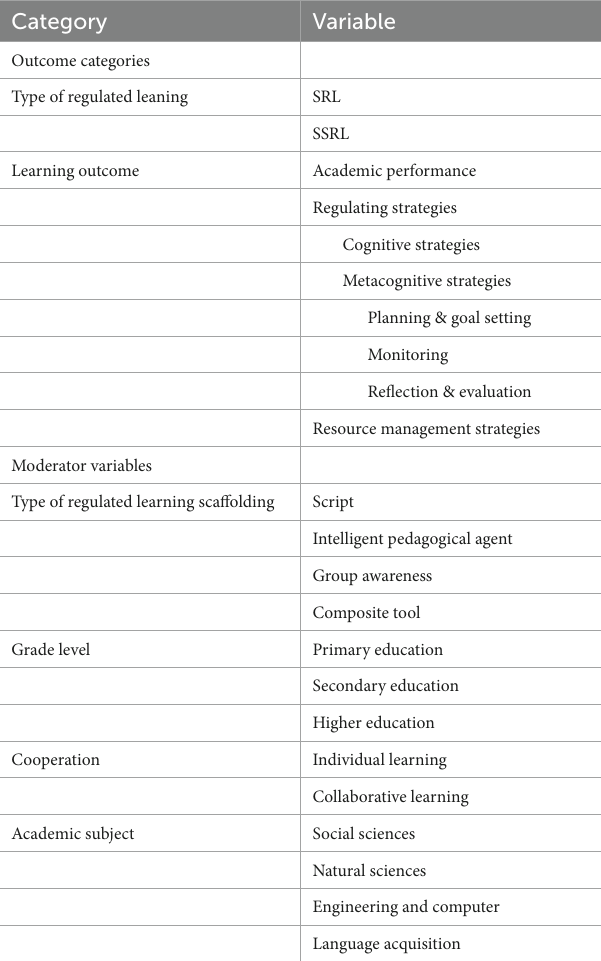
TABLE 1 Overview of outcome categories and moderating variables included in the